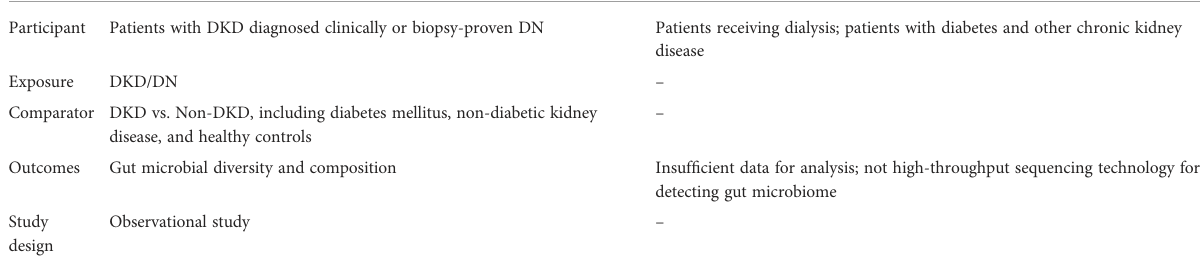
TABLE 1 Eligible criteria based on